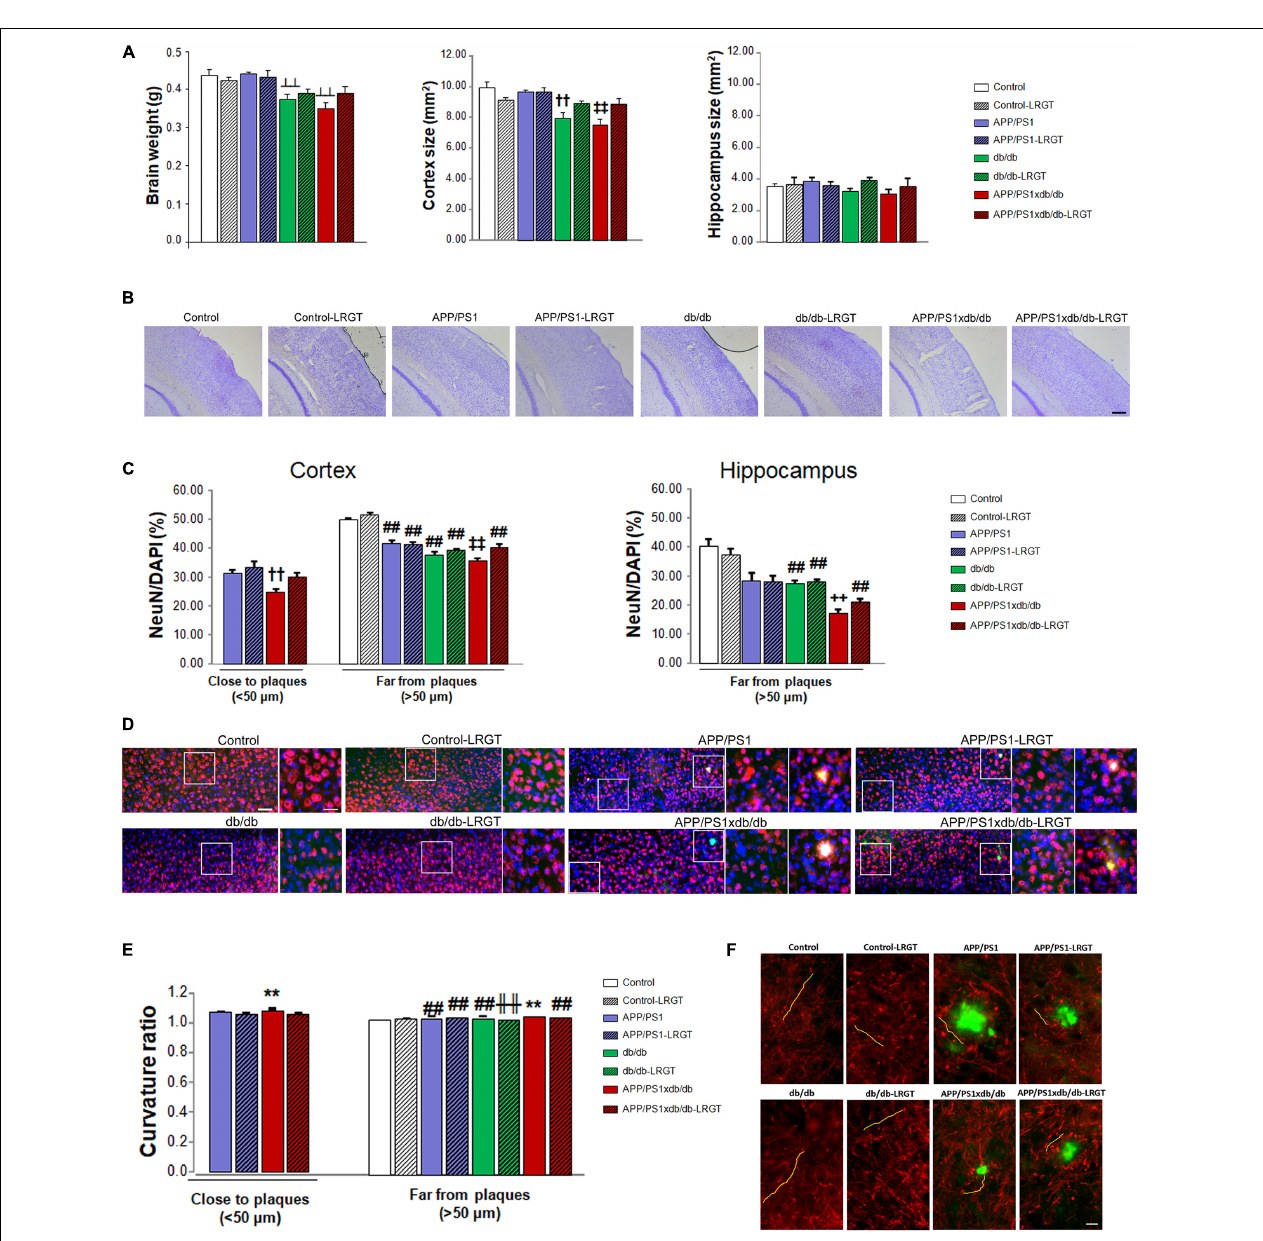
FIGURE 3 | Brain atrophy, neuronal density, and curvature are reduced by LRGT treatment. (A,B) Brain weight, cortex and hippocampal size, (C,D) NeuN/DAPI ratio, and (E,F) axonal curvature ratio were analyzed in all four genotypes (Control, APP/PS1, db/db, and APP/PS1xdb/db) under study and compared with animals by week 26, after 20 weeks on LRGT treatment (500 µ g/kg/day) (complete statistical analysis included as a Supplementary Material ). (A) Long-term LRGT limited brain weight loss ( p < 0.01 vs. Control, Control-LRGT, APP/PS1, APP/PS1-LRGT, db/db, and APP/PS1xdb/db). Cortical size was significantly improved by the LRGT treatment ( p < 0.01 vs. Control, Control-LRGT, APP/PS1, APP/PS1-LRGT, db/db-LRGT, and APP/PS1xdb/db-LRGT; †† p < 0.01 vs. Control, Control-LRGT, APP/PS1, and APP/PS1-LRGT). No differences were observed in the hippocampus. Data are representative of 4–5 animals. (B) Illustrative example of cresyl violet staining showing reduced cortical size in db/db and APP/PS1xdb/db mice. Scale bar = 200 um. (C) Neuronal density was reduced in the proximity of amyloid plaques in APP/PS1xdb/db mice, and LRGT ameliorated this situation ( †† p = 0.008 vs. APP/PS1 and APP/PS1-LRGT). A similar profile is observed in cortical and hippocampal areas with no amyloid plaques ( p < 0.001 vs. Control, Control-LRGT, APP/PS1, APP/PS1-LRGT, db/db-LRGT, and APP/PS1xdb/db-LRGT; ## p < 0.01 vs. Control and Control-LRGT; + + p < 0.01 vs. Control, Control-LRGT, APP/PS1, APP/PS1-LRGT, db/db, and db/db-LRGT). Data are representative of five animals. (D) Illustrative example of NeuN (red) and DAPI (blue) staining in areas located in the proximity of amyloid plaques (TS staining, green) and in areas without amyloid plaques. Zoom-in images of representative regions are marked by white squares and presented next to the original image, including areas with and without amyloid plaques. Scale bar = 50 µ m, insets scale bar = 25 µ m. (E) LRGT reduced curvature ratio in the proximity of amyloid plaques (** p = 0.004 vs. rest of the groups) and in areas free of amyloid plaques (** p < 0.01 vs. rest of the groups, ## p < 0.01 vs. Control and Control-LRGT, p < 0.01. vs. Control) (complete statistical analysis included in Supplementary Material ). Data are representative of five animals per group (308–920 neurons/group). (F) Illustrative examples of SMI-312 (red) and TS (green) staining in the proximity of and far from amyloid plaques (yellow lines mark representative neurites). Scale bar = 10 µ m.